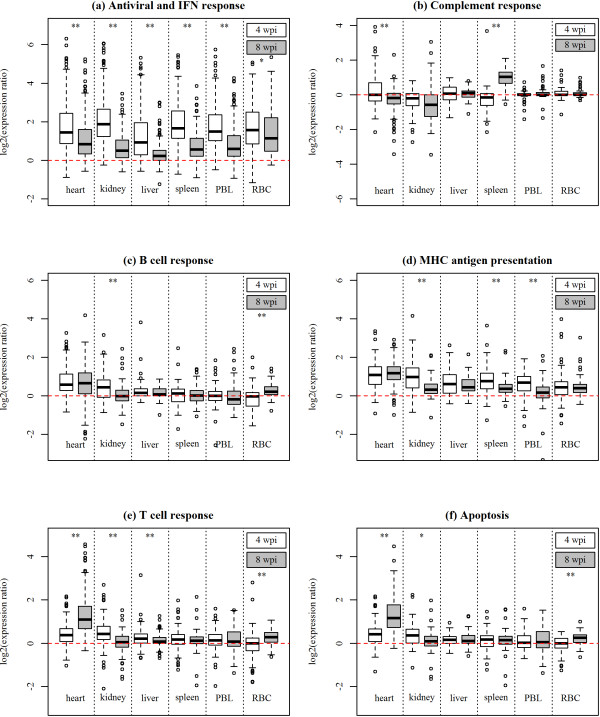
Regulation of immune responses in different tissues. Box plots show log2-ER (expression ratios) for all genes included in the six gene sets (a-f) resulting from microarray analysis of infected versus control fish from the study in different tissues and from two time points; early infection stage (4 wpi) and peak cardiac pathology/viral load (8 wpi). Details on the box plots are described in the legend of Figure 4.